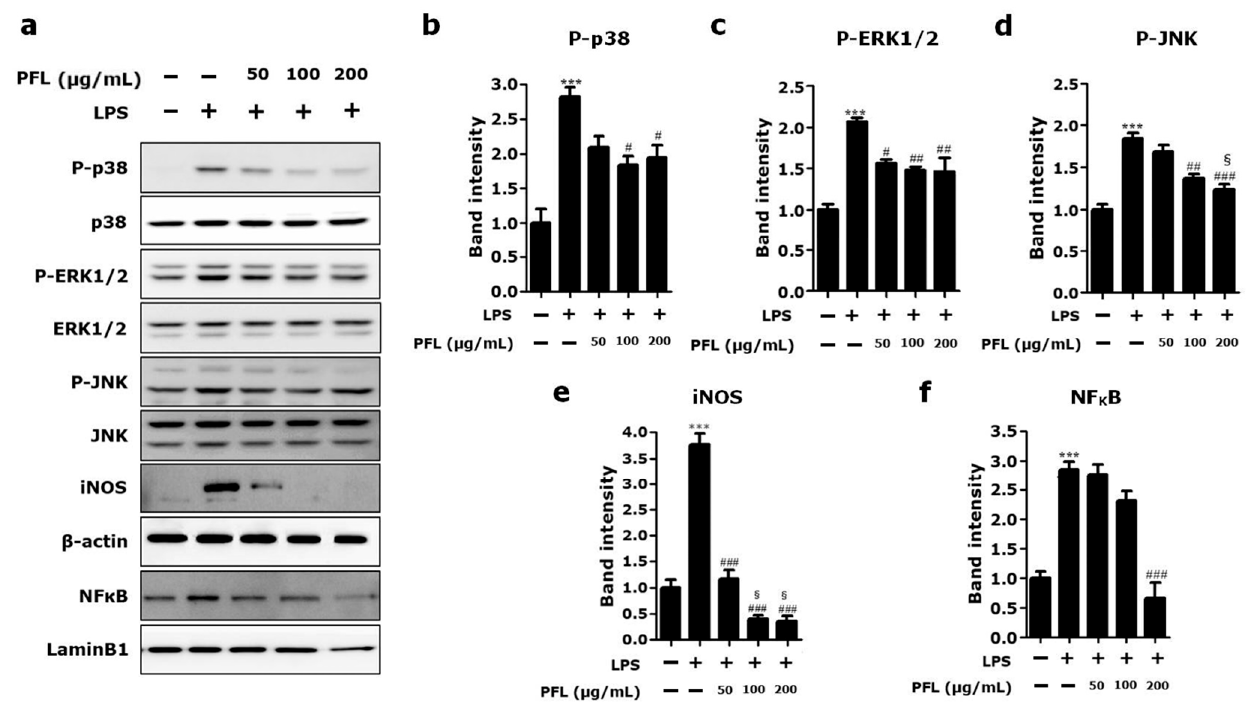
Figure 6. Effect of PFL on the expression of selected proteins in LPS-stimulated BV-2 cells. BV-2 cells were pretreated with the indicated doses of PFL for 12 h and further treated with 1 μ g/mL lipopolysaccharide (LPS) for 24 h. By Western blot, ( a ) representative protein band images were obtained, and the amounts of phosphorylated MAPKs, including ( b ) p-p38, ( c ) p-ERK1/2, ( d ) p-JNK, ( e ) iNOS, and ( f ) nuclear NF κ B, were semi-quantitatively assessed. The band intensities of p-p38, p-ERK1/2, p-JNK, and iNOS were normalized by β -actin, whereas nuclear NF κ B intensity was normalized by LaminB1, each used as internal controls. Data were expressed as the fold of the controls and collected from at least three independent experiments. Values are presented as the mean ± SEM (*** p < 0.001 vs. LPS-untreated; # p < 0.05, ## p < 0.01, and ### p < 0.001 vs. LPS only-treated; § p < 0.05 vs. 50 μ g/mL PFL-treated).